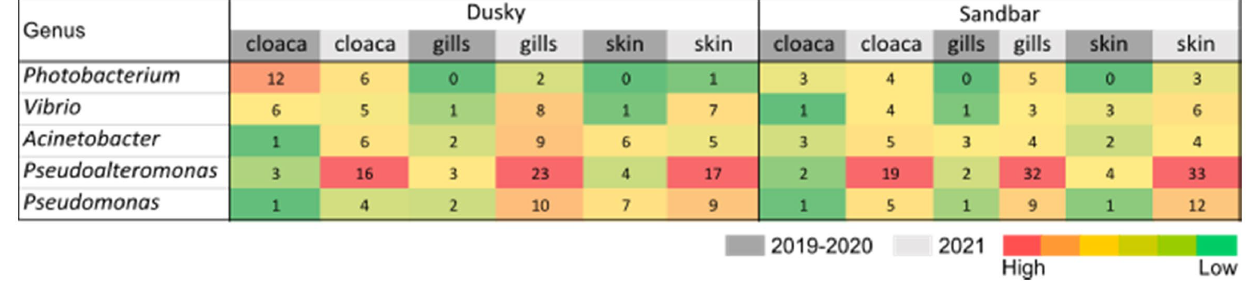
TABLE 1 Comparison of dominant bacteria between 2019 and 2020 seasons and the season 2021.